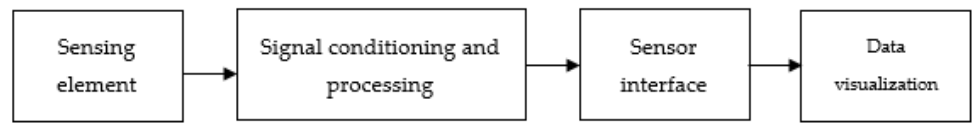
Figure 3. Traditional sensors logic diagram.